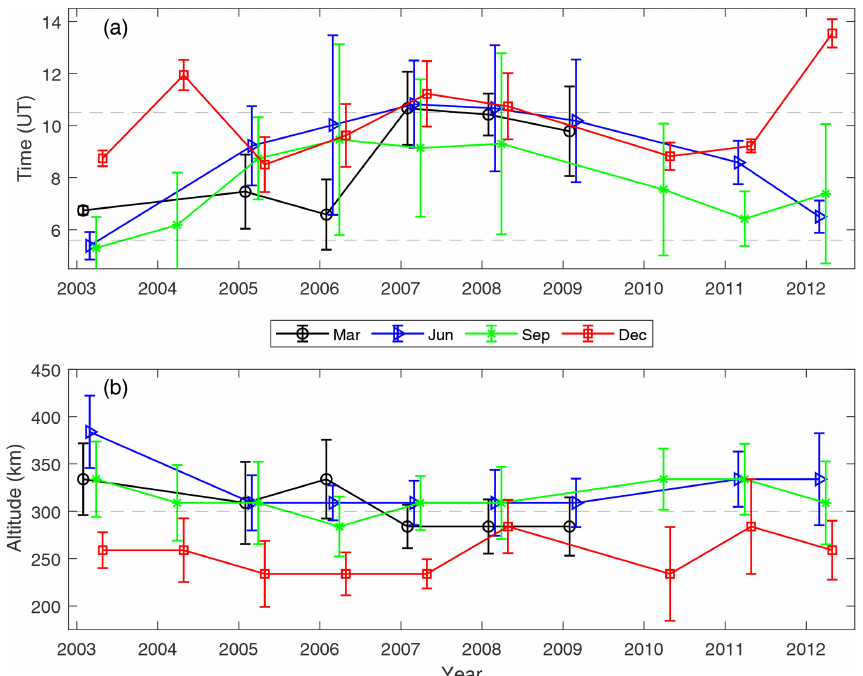
Figure 4. Peak time (a) and altitude (b) echo occurrences along the solar cycle divided by seasons. The error bars show the standard deviation of